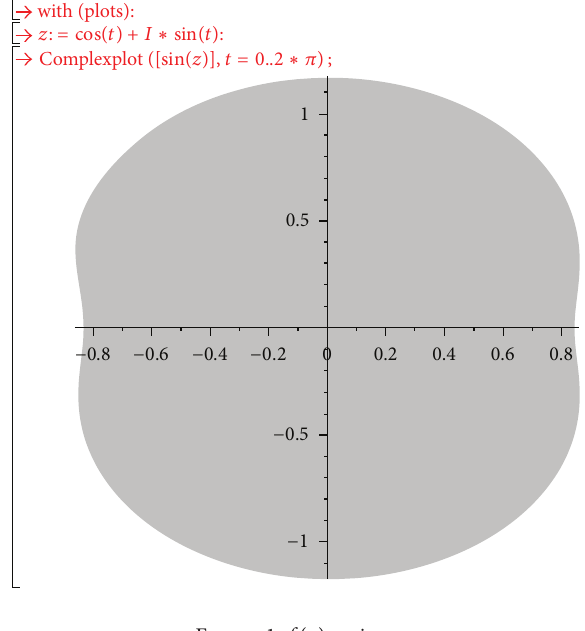
Figure 1: 𝑓(𝑧) = sin 𝑧